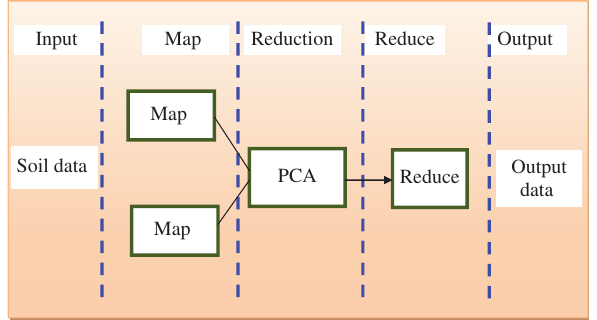
Figure 2: Flow Diagram of the MapReduce